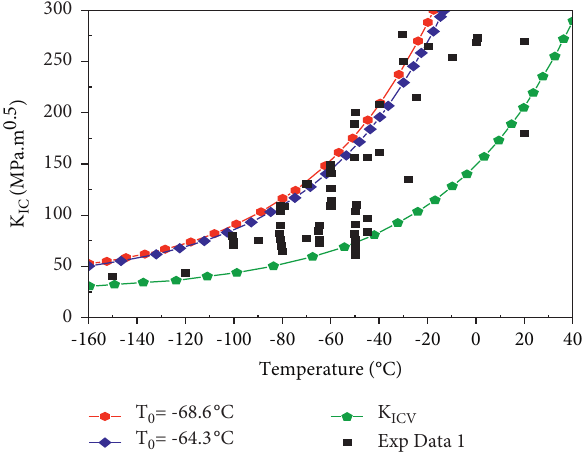
Figure 17: Comparison of two fracture toughness curves modeled by master curve method.